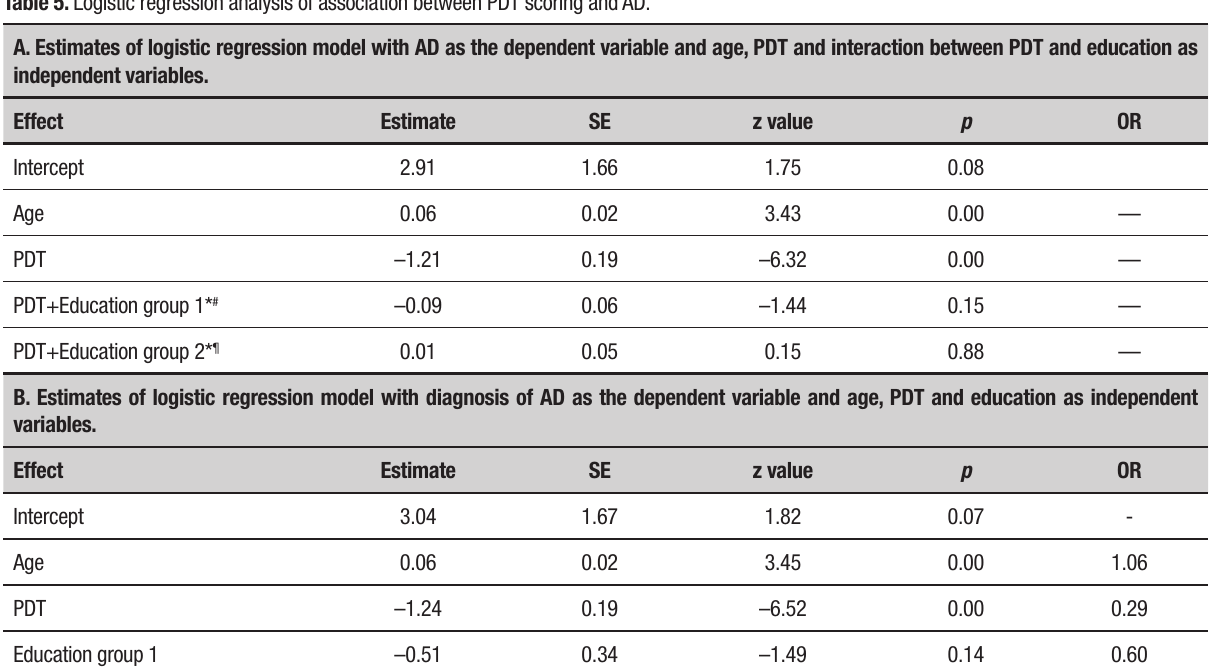
Table 5. Logistic regression analysis of association between PDT scoring and AD. A. Estimates of logistic regression model with AD as the dependent variable and age, PDT and interaction between PDT and education as independent variables.